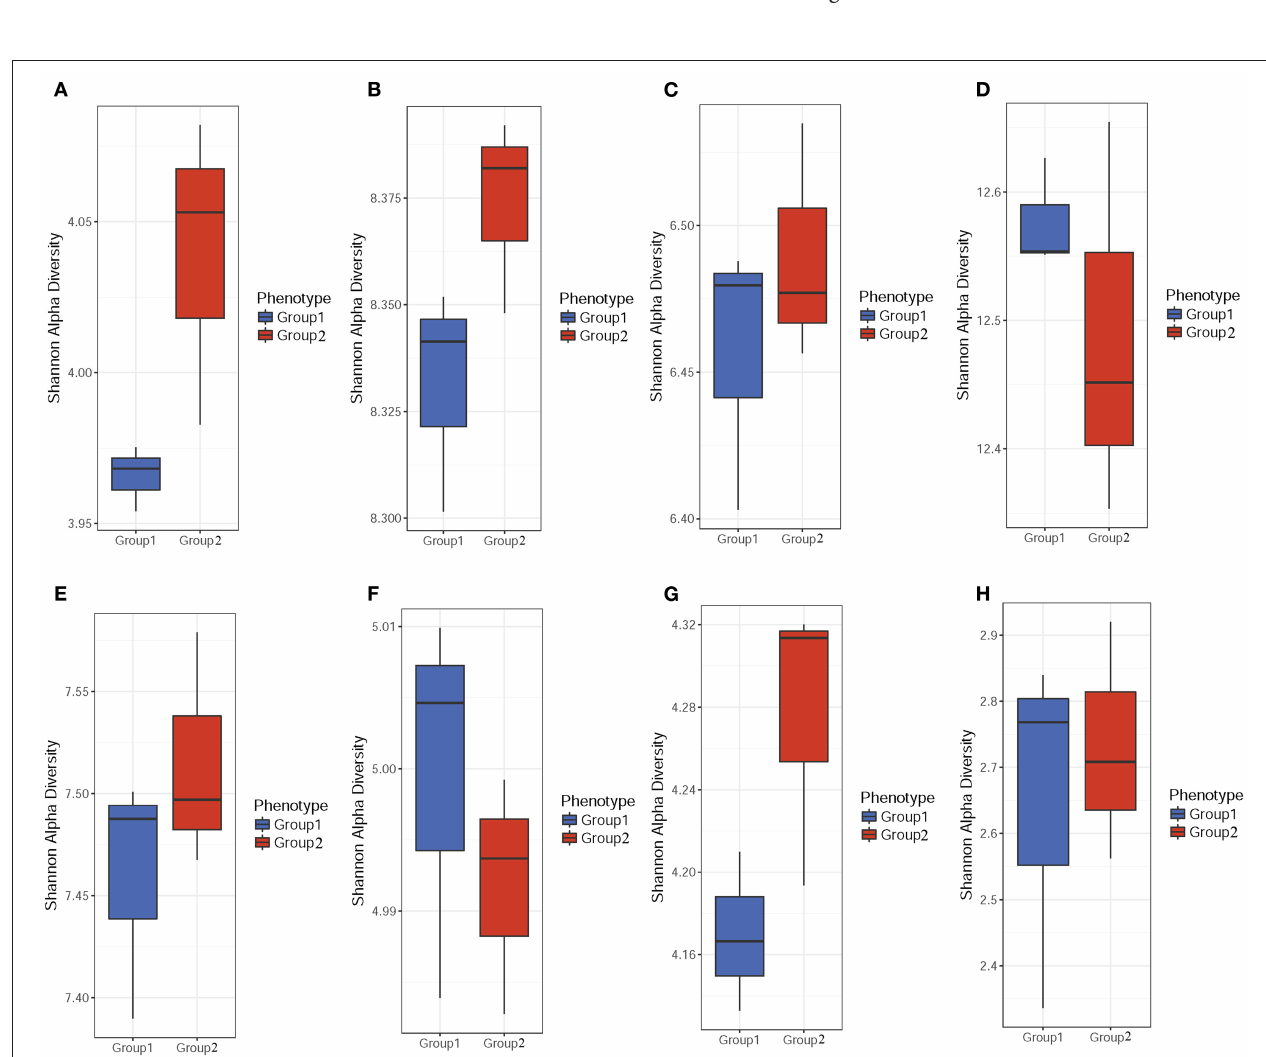
FIGURE 1 | α -Diversity analysis of the pig gut microbiome composition. Stool samples were obtained from colistin and control groups. The Shannon H index was used to determine gut sample diversity using ARDB (A) , eggNOG (B) , Enzyme (C) , Gene (D) , KO (E) , Module (F) , Pathway (G) , and Taxonomy (H) .